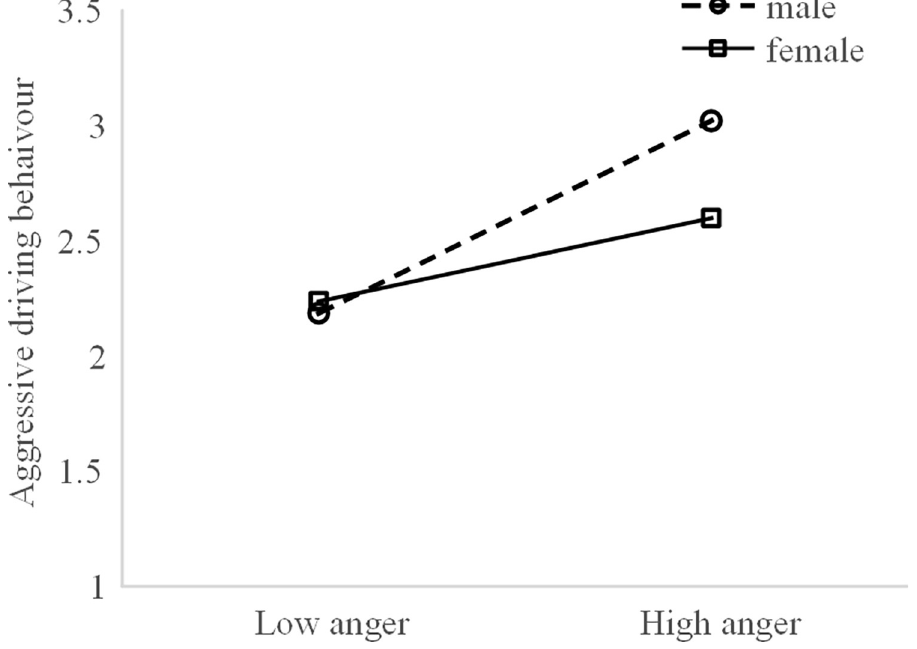
Fig 7. Simple slope analysis of aggressive behaviours-anger ×